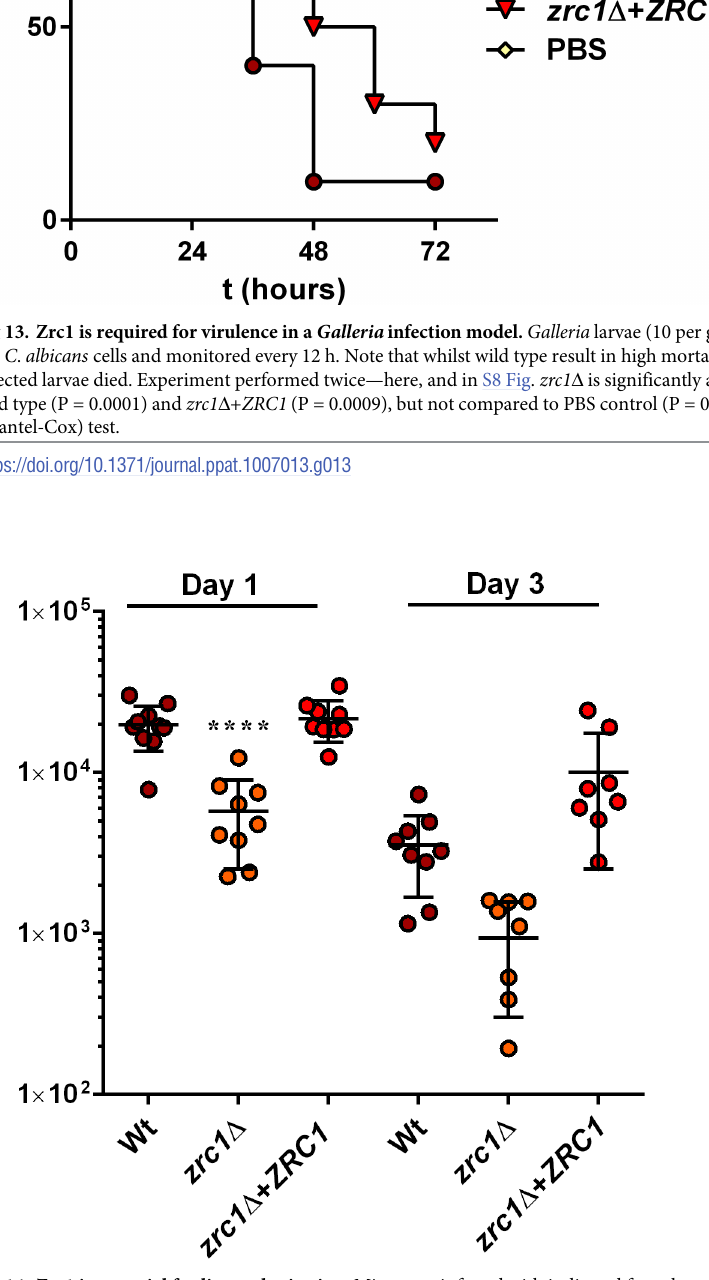
Fig 14. Zrc1 is essential for liver colonisation. Mice were infected with indicated fungal strains and liver colonisation determined by plating CFUs on day one and day three post-infection. Asterisks indicate significant difference compared to wild type and revertant,